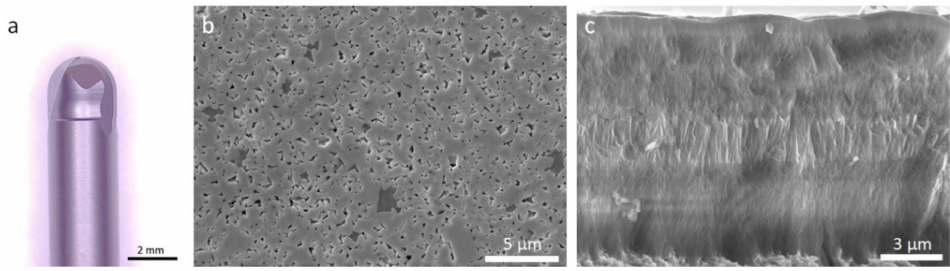
Figure 2. Diamond-coated end mill ( a ) and microstructural characterization of ( b ) the WC-7Co tool and ( c ) the multilayer diamond